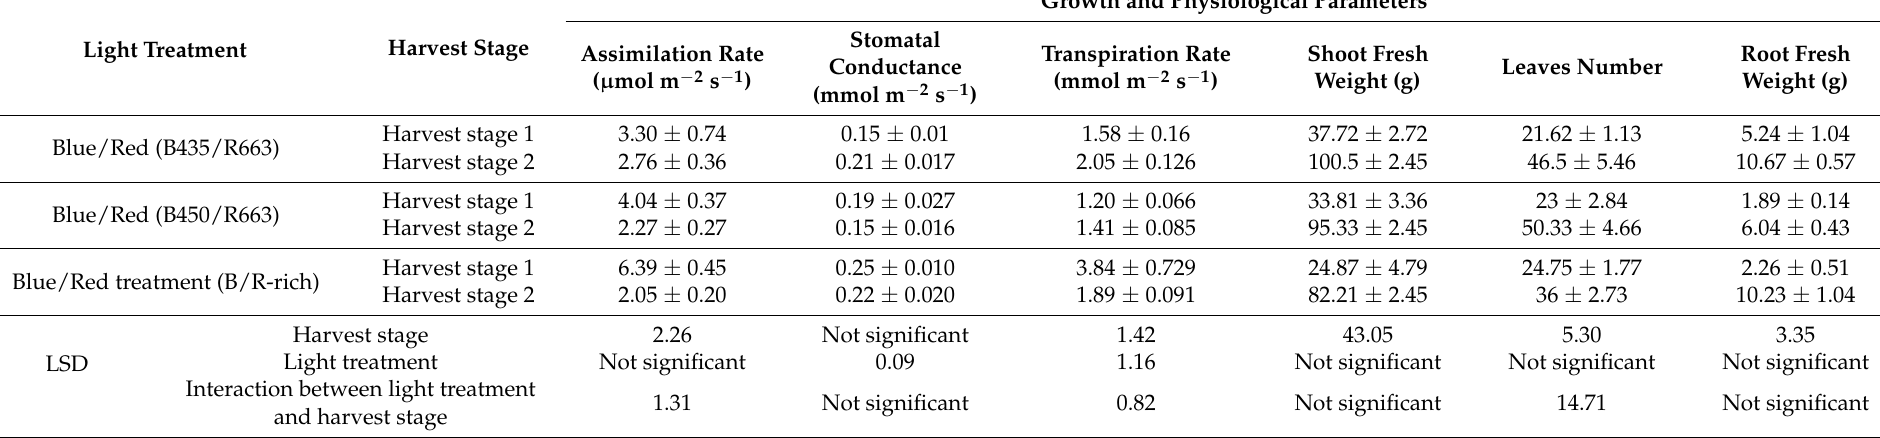
Table 3. The effects of low light intensity of different LEDs treatments on A: Assimilation rate (LSD for harvest stages = 2.26 ( p = 0.00), for treatments = no significance ( p = 0.062), and for interaction = 1.31 ( p = 0.00)). B: Stomatal conductance (LSD for harvest stages = no significance ( p = 0.590), for treatments = 0.09 ( p = 0.002), and for interaction = no significance ( p = 0.118)). C: transpiration rate (LSD for harvest = 1.42 ( p = 0.038), for treatments = 1.16 ( p = 0.00), and for interaction = 0.82 ( p = 0.010)). D: Shoot fresh weight (g) (LSD for harvest = 43.05 ( p ≤ 0.001), for treatments = no significance ( p = 0.598), and for interaction = no significance ( p = 0.723)). E: Root fresh weight (g) (LSD for harvest = 3.35 ( p = 00), for treatments = no significance ( p = 0.86), and for interaction = no significance ( p = 0.072)). F: Leaves number (for harvest stage ( p ≤ 0.001), for light treatment ( p = 0.277) for the interaction between harvest stage and light treatments ( p =